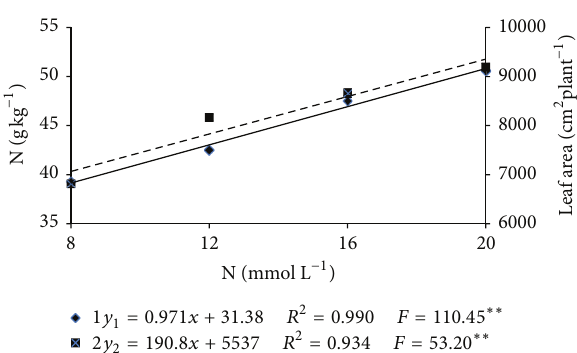
Figure 1: N content in the leaf used for the evaluation of the plant nutritional status 46 days after transplantation (DAT) (Y1) and leaf area 89 DAT (Y2) as influenced by the concentrations of N in the nutrients